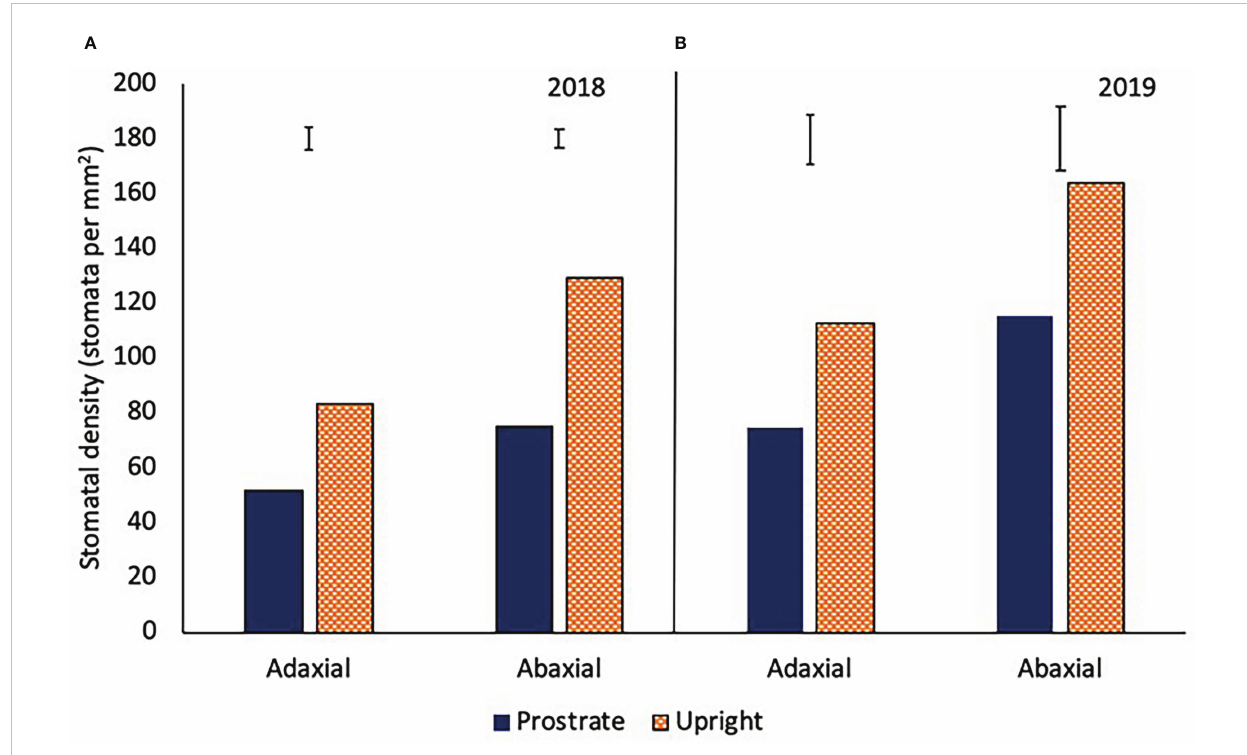
FIGURE 7 The stomatal density of the adaxial and abaxial leaves of two sugar beet varieties with a prostrate and upright canopy in 2018 (A) (adaxial LSD=7.7 DF=31 P<0.001, abaxial LSD=6.7 DF=31 P<0.001) and 2019 (B) (adaxial LSD=18.1 DF=31 P<0.001, abaxial LSD=23.1 DF=31 P<0.001). Sugar beet were grown under four different irrigation regimes, fully irrigated (Full), single drought (SD), double drought (DD) and continually water limited (Ltd) and averages over all the treatmetns are shown as there was no irrigation x variety